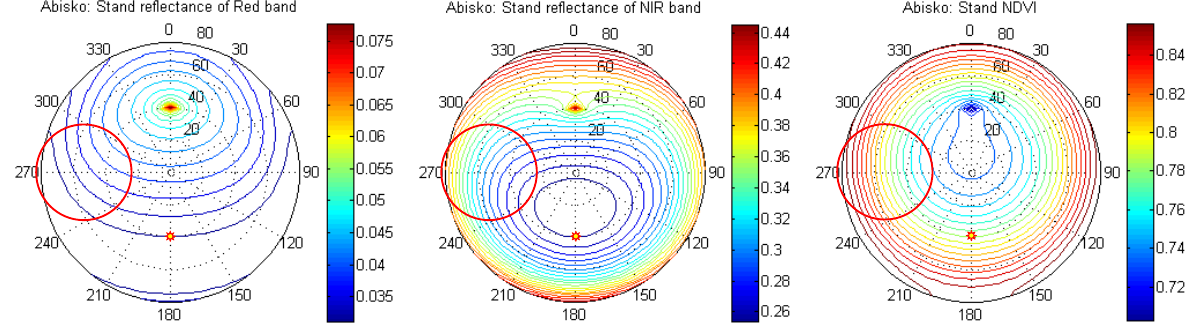
Figure 4. HCRF and sensor footprint at the Abisko forest stand as modeled with FRT [39]. The sensor is looking at 261° direction with an off-nadir angle of 55° and an FOV of 60°. The sun zenith angle is 40° at 180° relative azimuthal direction, shown as an asterisk. The sensor footprint ellipse is projected as a circle in the polar coordinate system (red